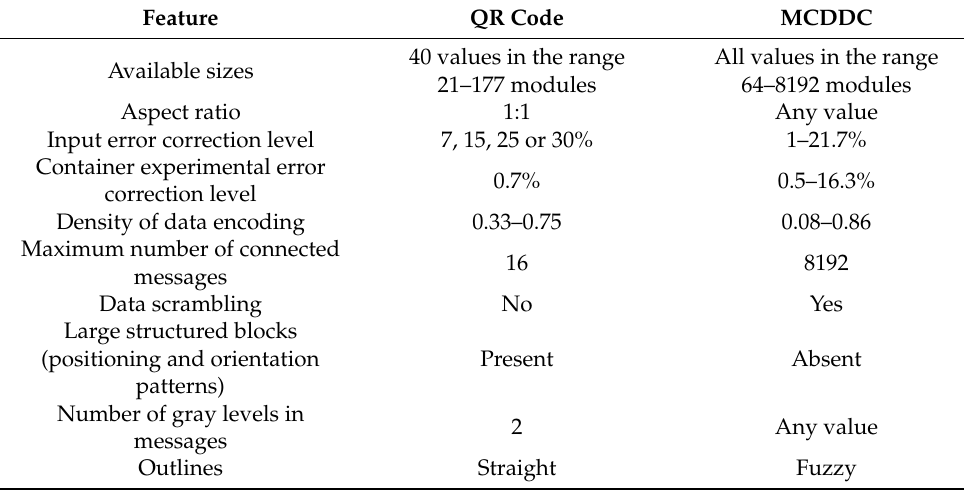
Table 1. Comparison of QR code and MCDDC